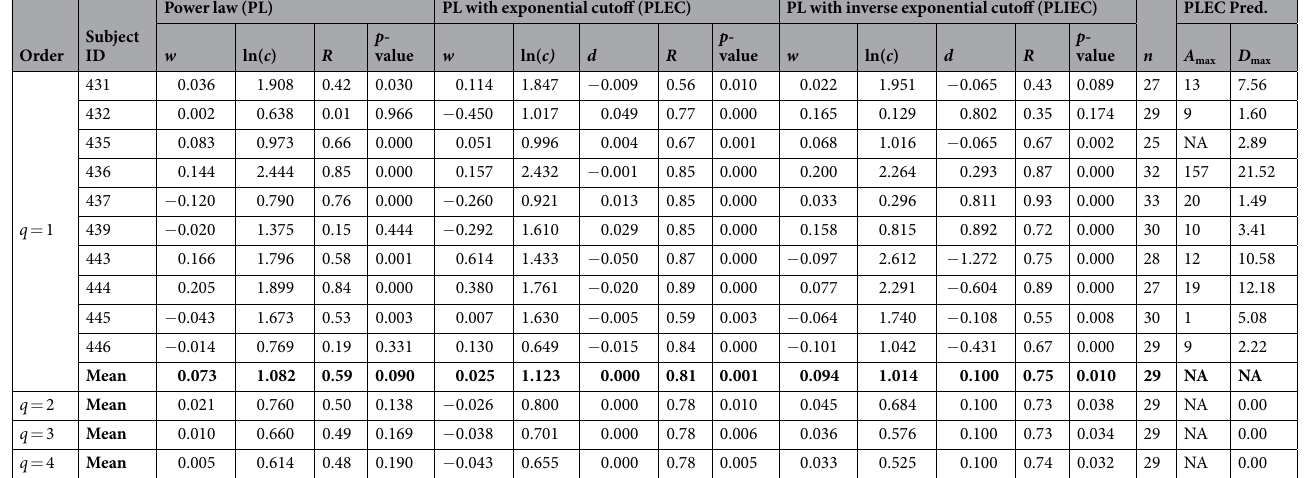
which corresponds to the traditional STR, does fall in the ranges reported in the literature. Since our study, to the best of our knowledge, is the first investigation of the DTR beyond richness level ( q = 0), we establish the first report on the alpha A DTR ranges for diversity order q = 1–4 as 0 .005–0.073 for the HVMs. Similarly, since we are not aware of any report on the beta- diversity scaling of B DTR, we establish the zero-order B DTR of the HVM as 0.407, and the range of the B TDR for order q = 1–4 as 0.018–0.081. The possible negative exponent ( w ) in PL and its extended versions (PLEC & PLIEC) reveal an important difference between DAR (Ma) 49 and DTR: the spatial scaling is usually positive, but the temporal scaling can be negative. That is, diversity could decrease with time , which makes sense even intuitively. Visualization of the DTR models. Figure 1 shows the 3D-graph of the PL exponent ( w ) of 32 alpha-DTR or A DTR models for 32 subjects at each diversity orders ( q = 0–4), and Fig. 2 shows the beta-diversity counterpart, i.e ., PL w of B DTR. Figures 3 and 4 show the PLEC counterparts, i.e ., PLEC w of A DTR and PLEC w of B DTR, respectively. Figure 5 shows the 3D-graph alpha-MAD or maximal accumulation alpha diversity , predicted by the A DTR models for each of the 32 subjects at each diversity order ( q = 0–4), and Fig. 6 shows the beta-diversity counterpart, i.e ., beta-MAD or maximal accumulation beta diversity , predicted by the B DTR models. Both Figs 1 and 2 show that negative PL w -values exist widely in DTR; especially with alpha diversity-time scaling ( A DTR), w was drawn within the range between [–0.523 and + 0.656] (Fig. 1), a potential equilibrium